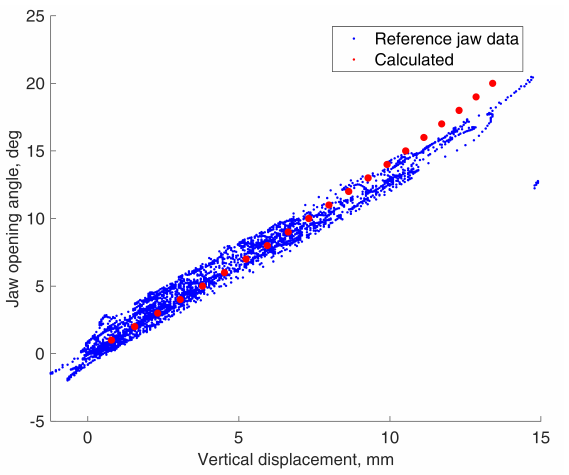
Figure 10. Vertical translation to jaw opening rotation